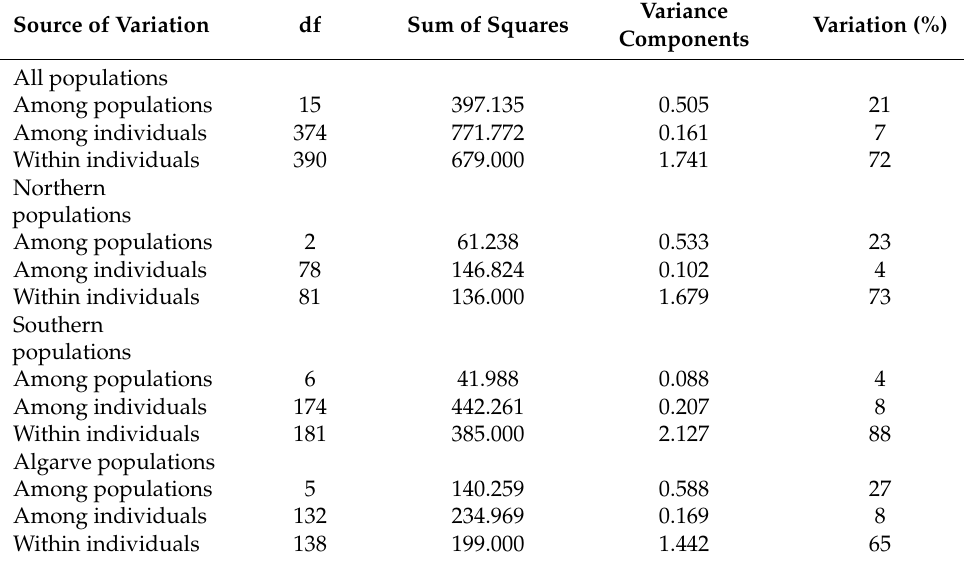
Table 3. Analysis of molecular variance (AMOVA) based on 6 SSR loci, considering all wild beet populations (northern, southern, and Islands), the B. vulgaris subsp. maritima northern populations, the B. vulgaris subsp. maritima southern populations and the Algarve populations ( B. vulgaris subsp. maritima / B. macrocarpa living in